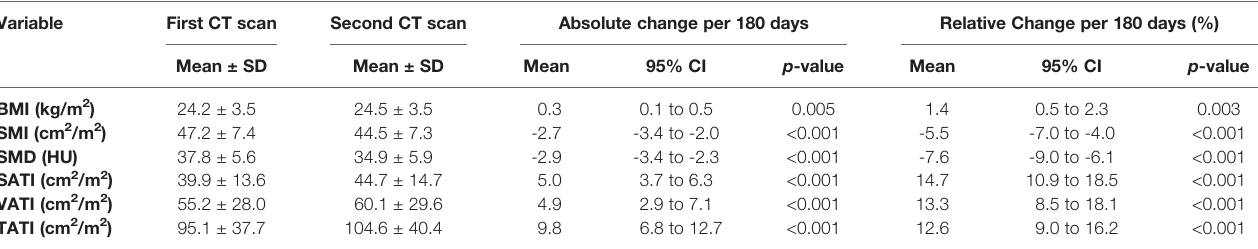
TABLE 2 | Change of body composition parameters during radiotherapy and androgen deprivation therapy.